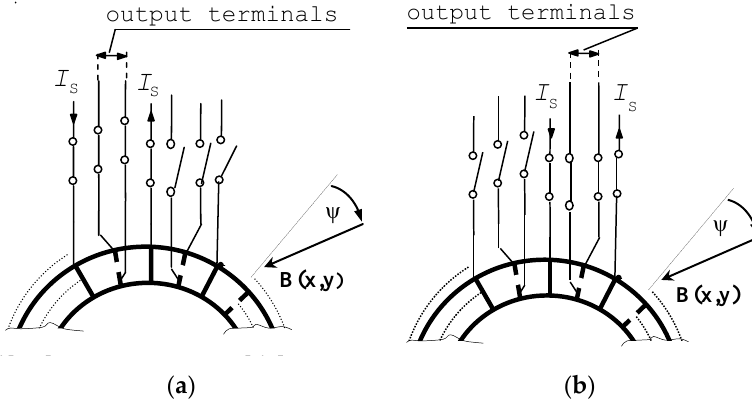
Figure 2. Circular Hall microdevice based on an original four-contact 2D Hall microsensor: ( a ) the active neighbouring contacts in position n; ( b ) the active contacts in position n +